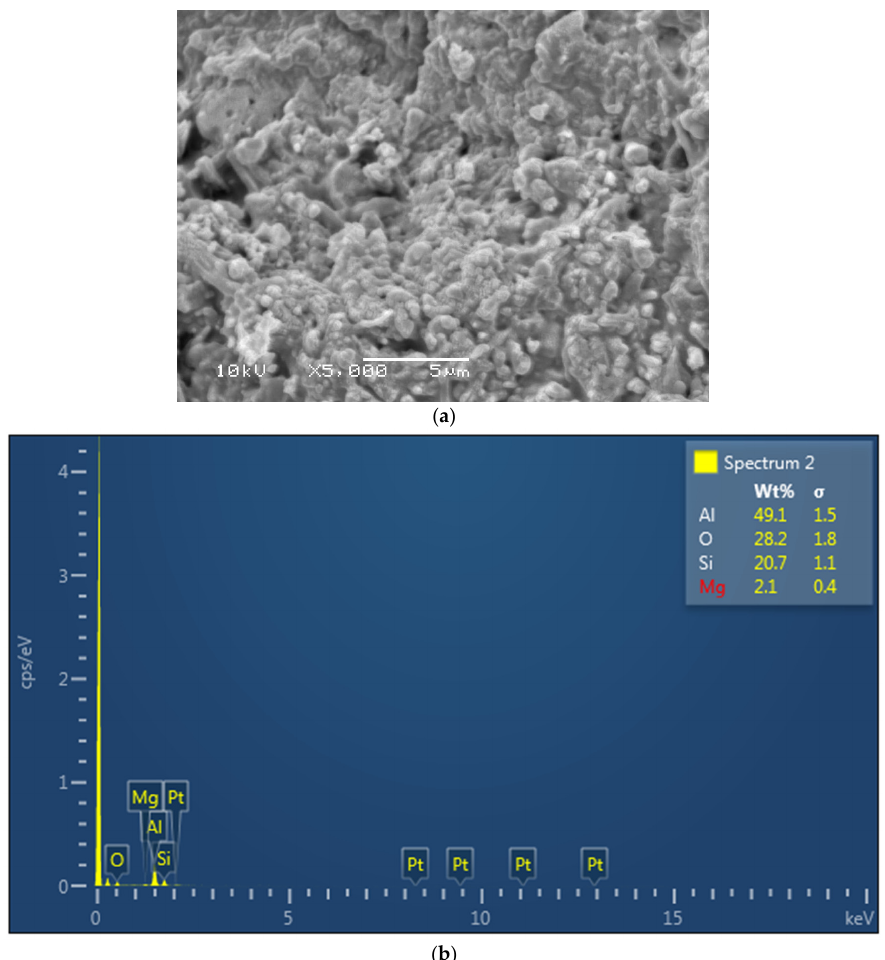
Figure 3. ( a ): Electron image of the bioactive cement, ACTIVA. ( b ):EDX for ACTIVA showing alumina, Si, and O from the aluminosilicate glass powder in the filler. The present study assessed the restorative microleakage and fracture loads of re- storative crowns luted with Ceramir, polymeric bioactive and resin cements, and color stability. The highest mean for the fracture loads were observed in Group 1 (49.5 ± 8.85) whereas the lowest mean was measured in the Group 3 (39.8 ± 9.16) cement (Table 1). ANOVA presented a significant difference among the study groups for failure loads ( p < 0.01). However, Group 2 showed a comparable failure load mean to Group 1 (resin ce- ment) (48.7 ± 6.59). Furthermore, Group 1 showed a greater range for fracture loads compared to the Group 2 specimens (ACTIVA). Figure 4 presents the failed crown specimen, post fracture testing of Group 1 (a), Group 2 (b), and Group 3 (c) specimens.